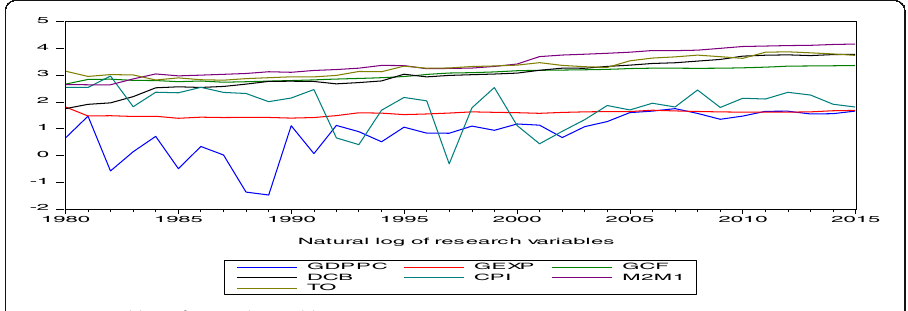
Fig. 1 Natural log of research